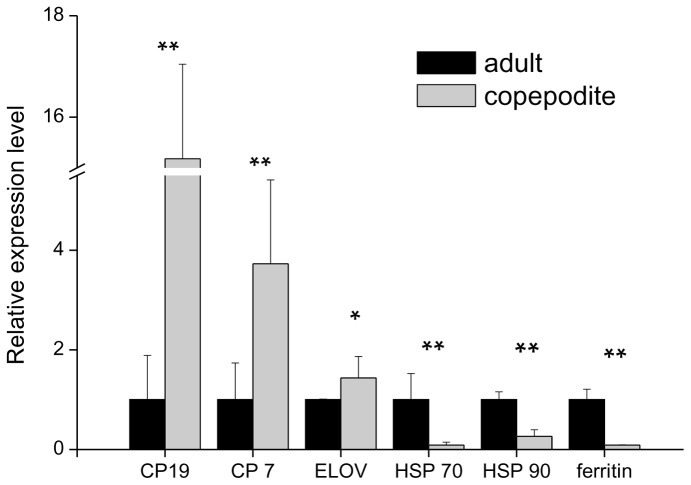
Real-time PCR validation of differentially expressed genes that may be involved in diapause.The values were normalized against actin. Significant levels were *P<0.05, **P<0.01, and values indicate the mean ± S.E.